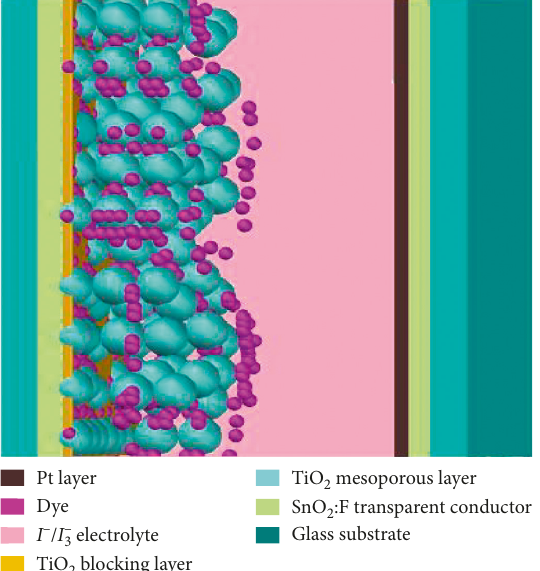
Figure 1: Structure of a dye-sensitized mesoporous TiO 2 solar Figure 1, a TCO (SnO :F) layer coated with a thin film of 2 platinum is seen, which constitutes the counterelectrode, whose function is to regenerate the electrolyte. The space between the active electrode and counterelectrode is filled − redox pair. with the electrolyte containing the I − / I 3